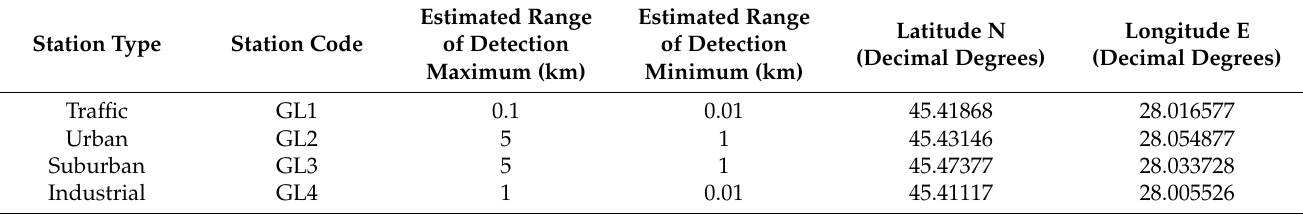
Figure 3. Map of Galati, showing the route of the UGAL mobile DOAS system, the locations of the main industrial platforms (Steel and Oil factories), and of the four Air Quality Monitoring Stations (AQMS) from Galati city (GL1-4). Table 2. Details of the local AQMS from Galati city [34].